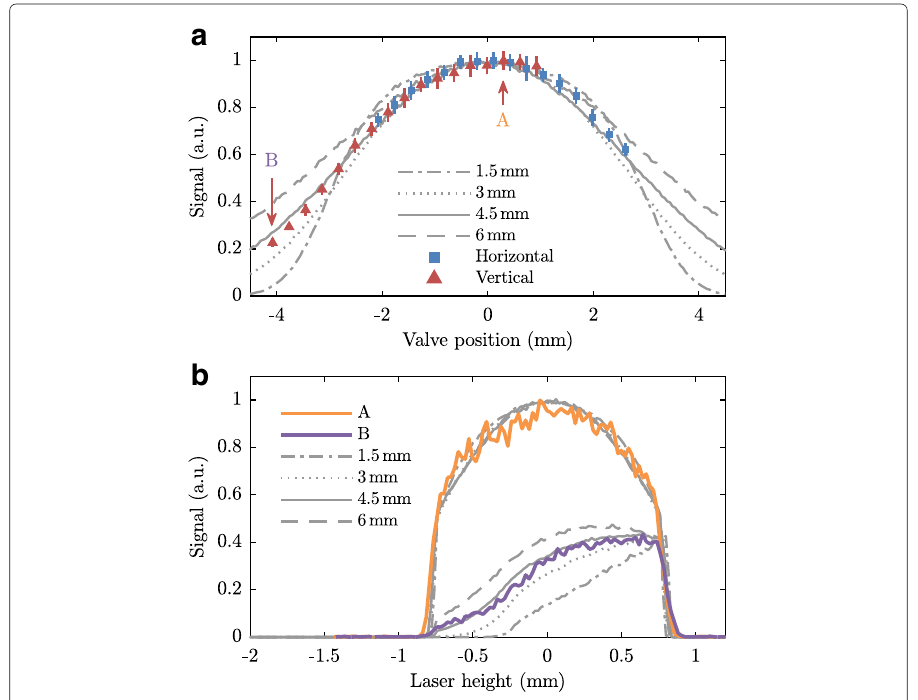
Fig. 9 a Argon signal in detection zone II as function of the horizontal (blue squares) or vertical (red triangles) position of the valve. Error bars represent standard errors of the means. b Scan of the vertical position of the laser focus when the valve is positioned close to the center (corresponding to arrow “A” in panel a ) or 4 mm below the center (corresponding to arrow “B” in panel a ). The grey lines in ( a ) and ( b ) show simulations with different values of the effective size of the beam